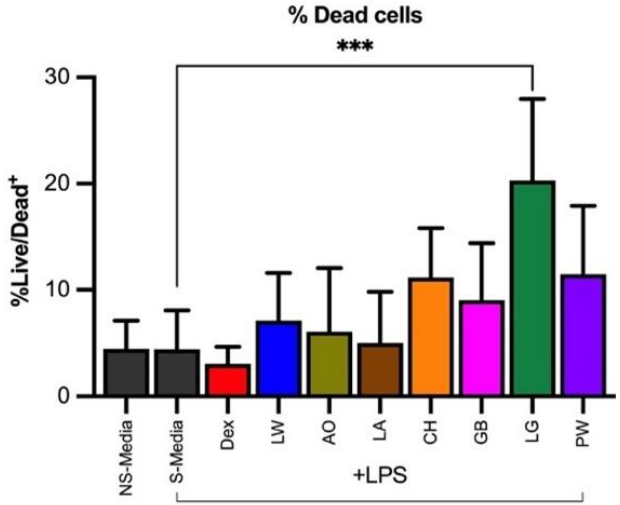
Figure 2. The percentage of dead cells in LPS-stimulated human PBMCs treated with the hydroeth- anolic extract of seven Wet Tropics plant species in two independent experiments after 20 h incuba- tion. Data expressed as mean ± SD of two independent experiments with blood from two donors (n